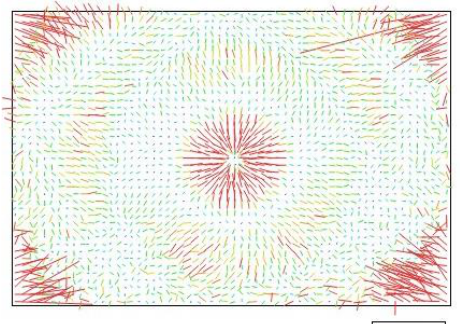
Figure 1. Image residuals for a DSLR camera equipped with a dome port after standard self-calibration. The image format is 6016×4016 pixels RESIDUALS SYSTEMATIC